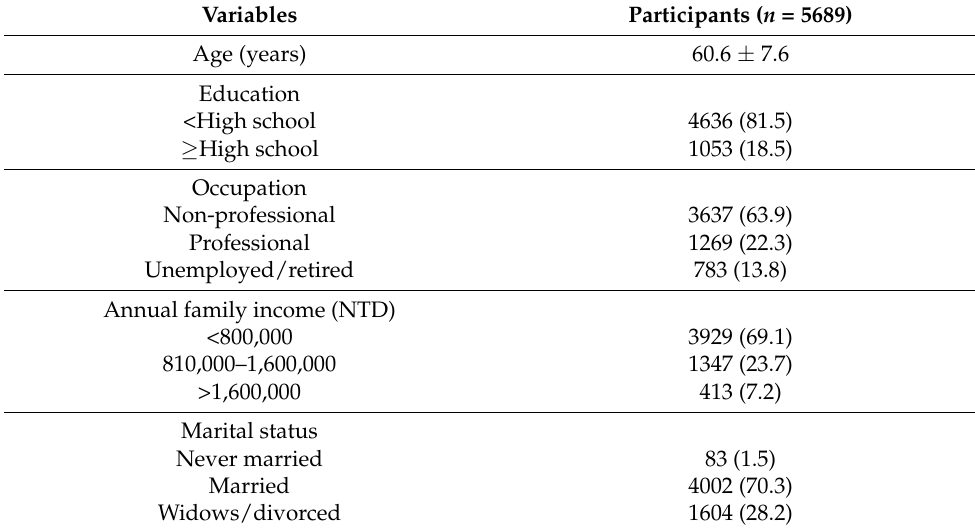
Table 1. Demographic and lifestyle characteristics of postmenopausal women aged ≥ 45 years ( n = 5689) 1 .